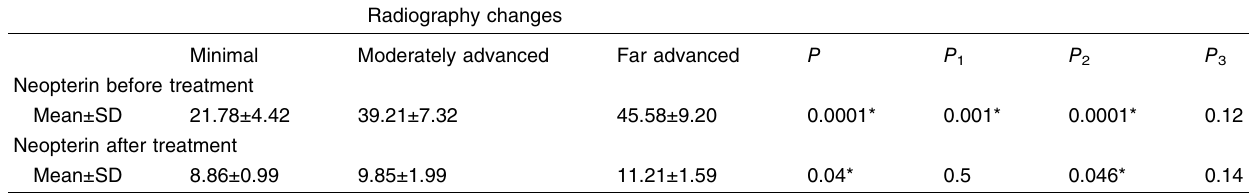
Table 4 Comparison between neopterin values before and after treatment in TB patients as regards radiographic changes Radiography changes